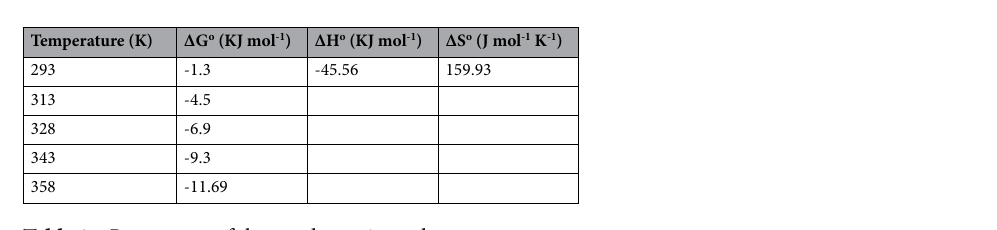
Table 3. Parameters of thermodynamic